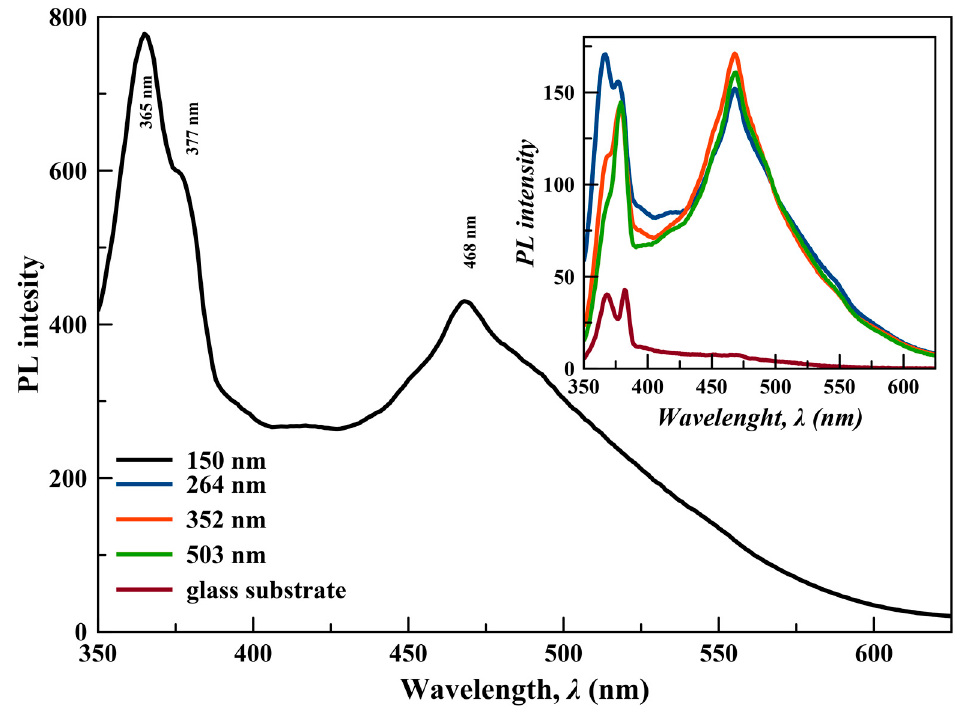
Figure 7. Photoluminescence spectra of NiO x thin films at different film thicknesses.